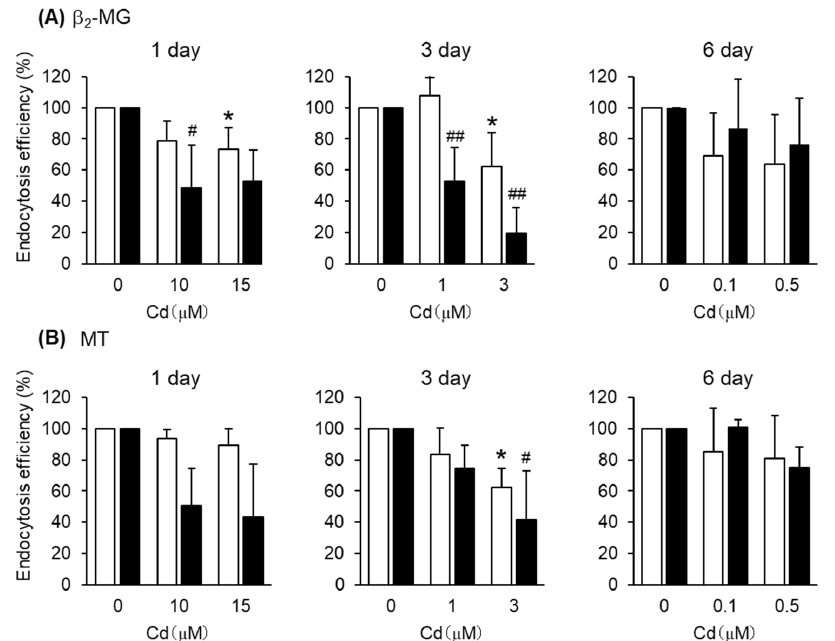
Figure 5. Effects of Cd on the endocytosis efficiencies of β 2 -MG and MT into S1 and S2 cells. S1 and S2 cells were exposed to CdCl 2 for 1, 3, and 6 days and then incubated with FITC- β 2 -MG ( A ) or FITC-MT ( B ) for 30 min. The endocytosis efficiencies were determined by flow cytometry and expressed as percentages of the control cells (no exposure to Cd). Open and closed columns represent S1 and S2 cells, respectively. Data are presented as means ± SD ( n = 3–4). Statistical significance of the dose dependence determined by one-way ANOVA was detected in the following settings: day1-S1 cells ( p < 0.05), day1-S2 cells ( p < 0.05), day3-S1 cells ( p < 0.05), and day3-S2 cells ( p < 0.01) for β 2 -MG ( A ), and day3-S1 cells ( p < 0.05) and day3-S2 cells ( p < 0.05) for MT ( B ). Statistical significances compared with the control cells determined by Bonferroni multiple comparisons are indicated as * p < 0.05, ** p < 0.01 (S1 cells) and # p < 0.05, ## p < 0.01 (S2 cells).